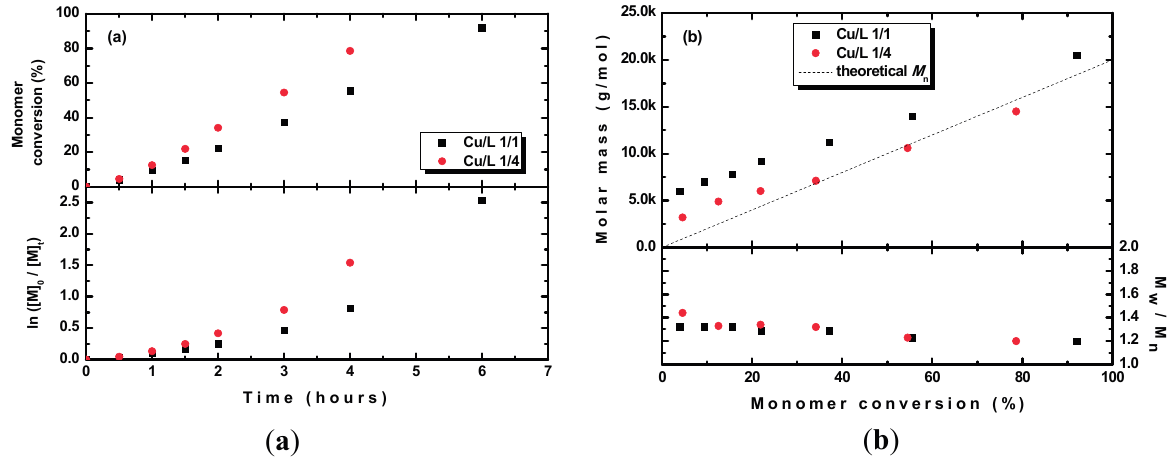
Figure 3. ( a ) Kinetic plots and ( b ) evolution of the molar mass and M w / M n with the conversion of MMA during photoRDRP using CuSO 4 ·5H 2 O/TPMA ratios of 1/1 and 1/4. BPN was used as an initiator. Experimental conditions: photoRDRP, MMA/BPN/Cu II = 200/1/0.04, irradiation at λ > 350 nm; [MMA] = 7.5 M, T = 35 °C, DMSO (25